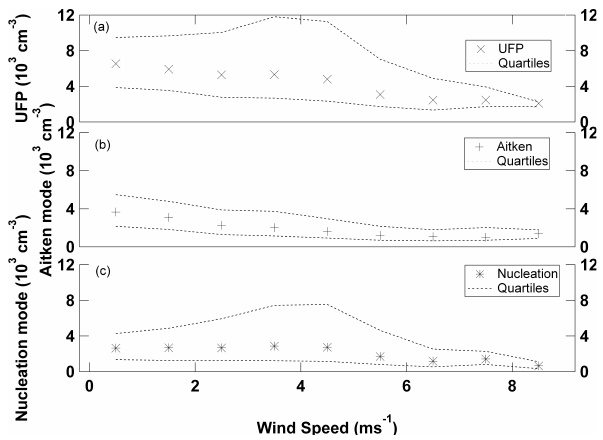
Fig. 7. Number concentration of (a) ultrafine (UFP), (b) Aitken mode and (c) nucleation mode particles and their variation as a func- tion of wind speed. The median number concentrations and the 1st and 3rd quartiles are